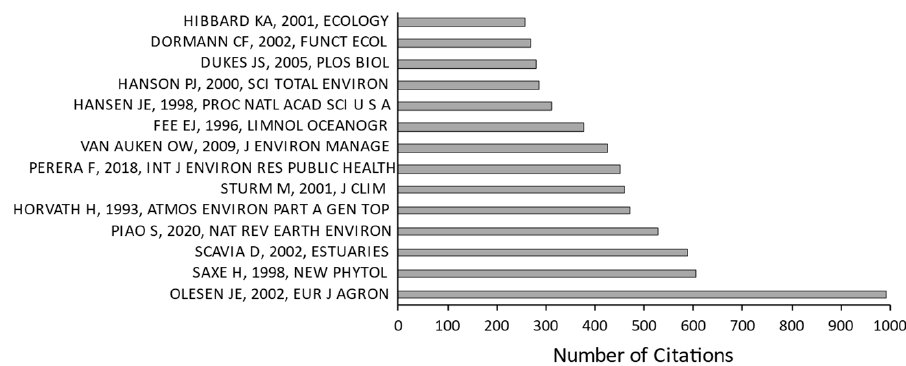
Figure 3. Documents selected for the literature review and presenting a citation count equal to or greater than 250.